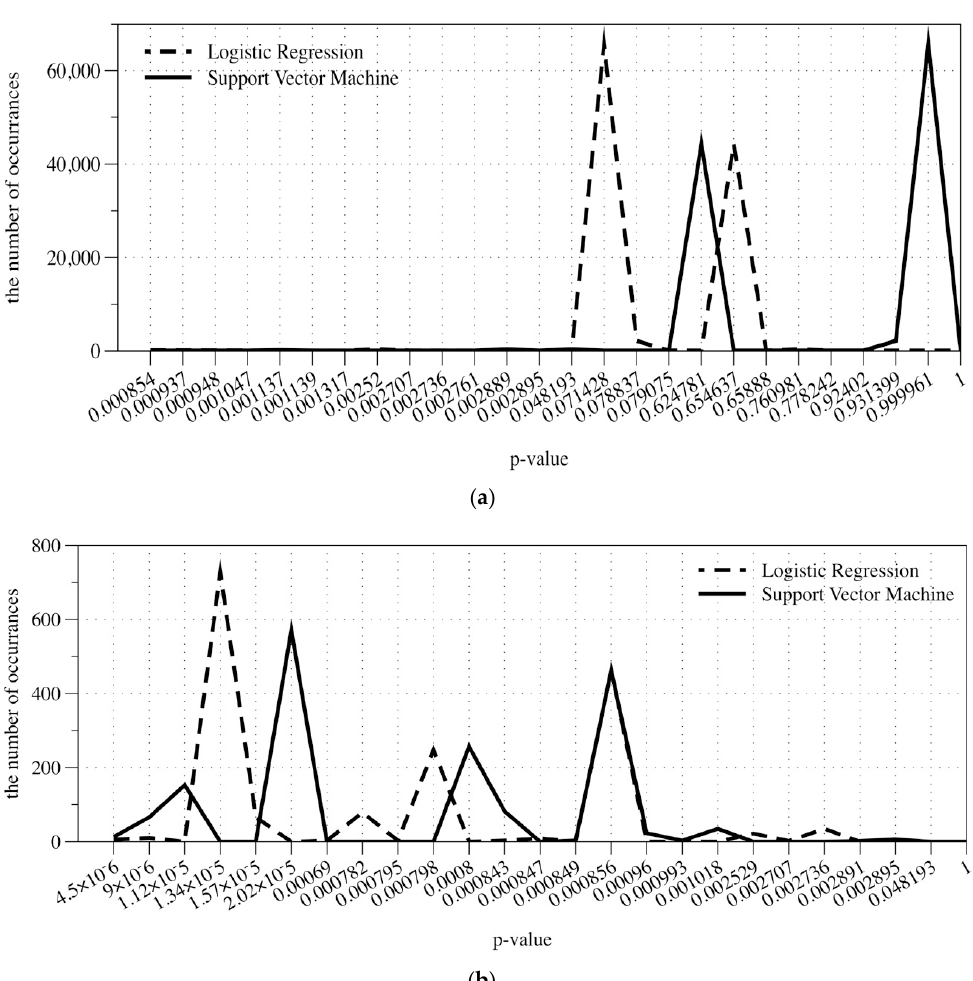
Figure 2. ( a ) Shows the relationship between the p -value of the normal log data in the test set and the number of occurrences. ( b ) Shows the relationship between the p -value of the anomaly log data in the test set and the number of occurrences. Normal logs are concentrated in areas with large p -values, while abnormal logs have very small p -values.